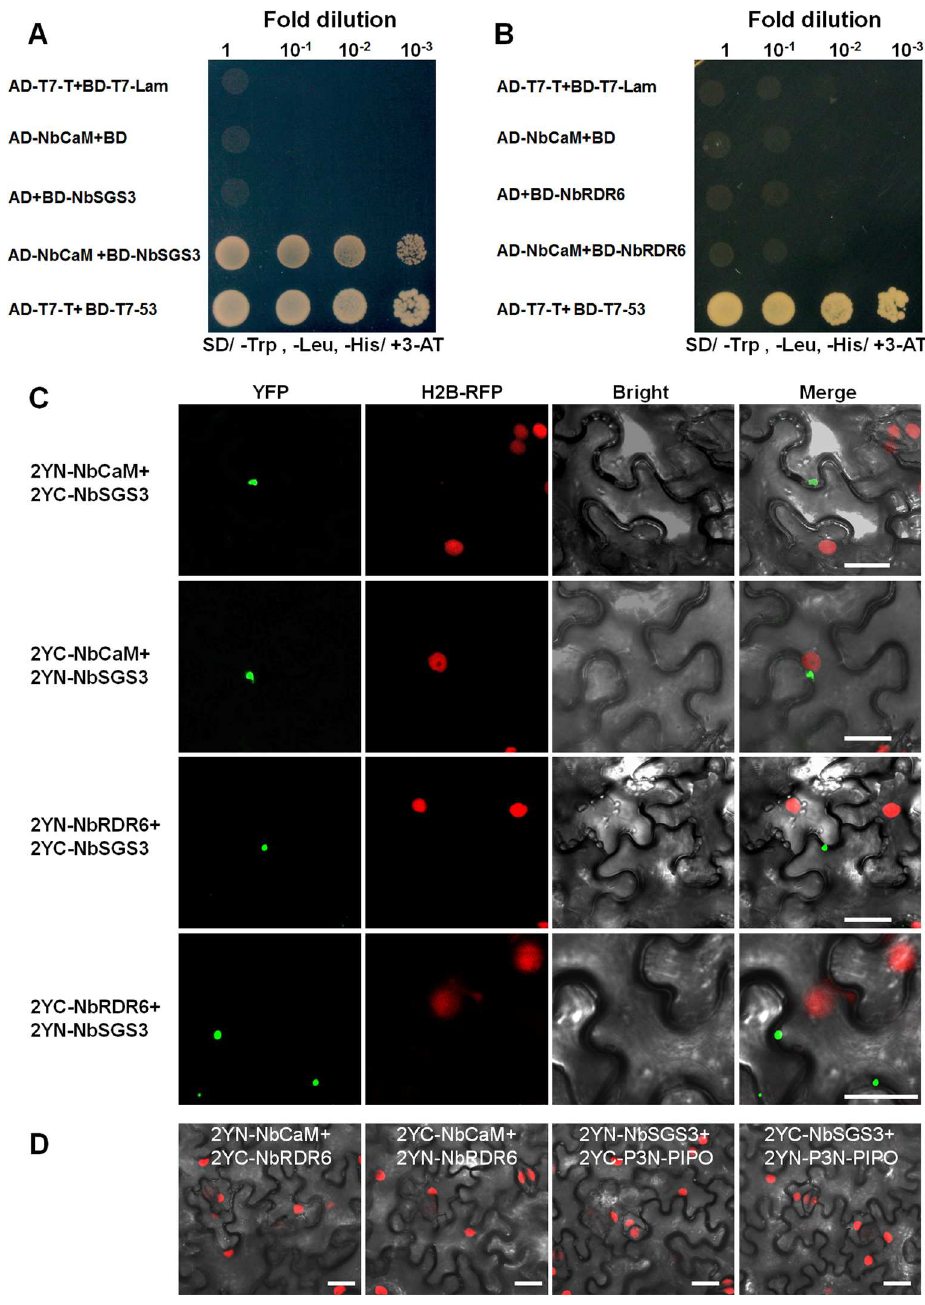
Fig 1. Interactions between NbCaM, NbSGS3 and NbRDR6. (A and B) Yeast two-hybridassays using NbCaMandNbSGS3 (A) or NbCaMandNbRDR6(B). Serial10-folddilutionsof yeast cellswere made as indicated.Cells co-transformed with AD-T7-T+BD-T7-53served as a positivecontrol, and cells co-transformed with AD-T7-T+BD-T7-Lam, or with empty vectors pGBKT7 (BD) andpGADT7 (AD) served as negative controls. BD, GAL4 DNA bindingdomain;AD, GAL4 activationdomain. (C and D) BiFC assays usingNbCaM, NbSGS3and NbRDR6in H2B-RFP transgenic N . benthamiana leavesat 48 hours post infiltration. YFP fluorescence (green) was observedas a consequenceof complementation of NbCaMandNbSGS3, or NbSGS3and NbRDR6tagged with 2YN and2YC. Nucleiof tobaccoleaf epidermalcellsare indicated by expression of the H2B-RFP transgene (red). No YFP fluorescence was found betweenpairwiseexpression NbCaMandNbRDR6,or NbSGS3 and P3N-PIPO ( D ).Singlechannels from the mergedimageshownin ( D ) are shownin S2 Fig. Bars = 25 μ